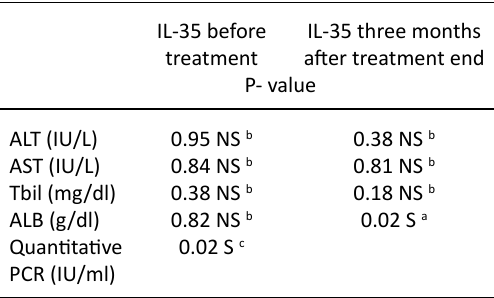
table 4. Correlation between T-regs and TH-17 frequency and laboratory investigations